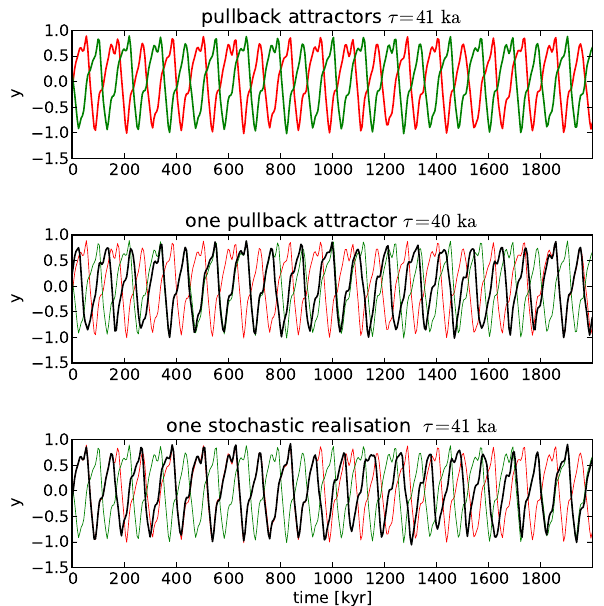
Fig. 9. Pullback solutions of the van der Pol oscillator forced by two periods (as in Figs. 7 and 8) as a function of τ . Forcing amplitude is γ = 0 . 6 and the other parameters are as on the previous figures. Vertical lines indicate the cases shown in Fig. 7.